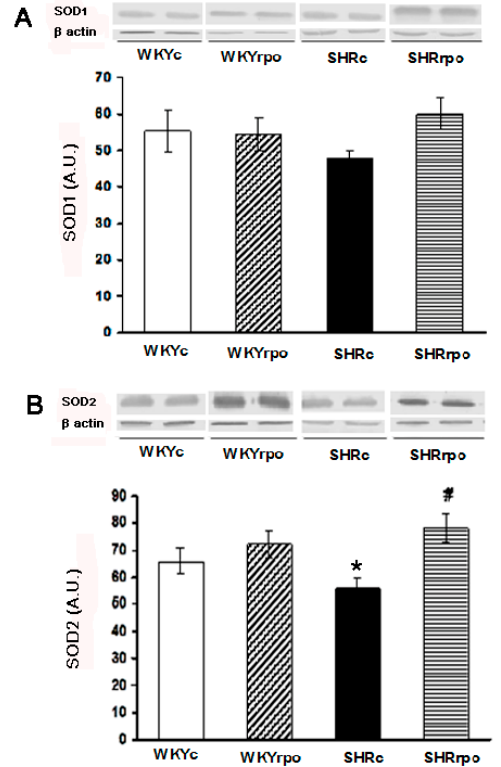
Figure 1. Effect of dietary red palm oil (RPO) supplementation on the protein expression of superoxide dismutase 1 (SOD1. ( A )) and superoxide dismutase 2 (SOD2. ( B )) in the left ventricle of normotensive and hypertensive rats. WKYc—Wistar Kyoto control rats; WKYrpo—WKY treated with RPO; SHRc—Spontaneously hypertensive rats; SHRrpo—SHR treated with RPO; Results are expressed as mean ± SEM; n = 5 in each group; * p < 0.05 versus control rats (WKYc); # p < 0.05 WKY/SHR versus treated with RPO; A.U.—Arbitrary units.